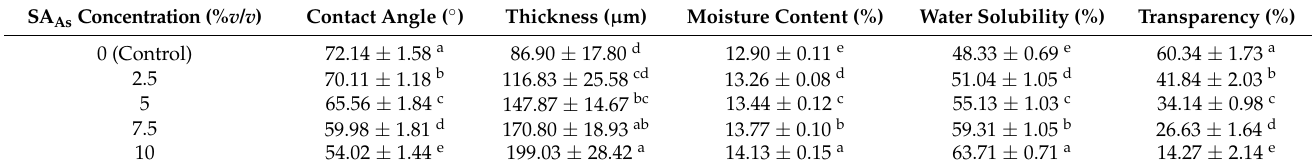
Table 1. Effect of SA As concentrations on physical properties of Salep mucilage edible indicator